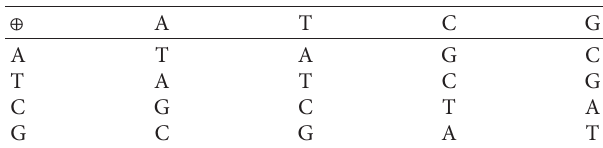
Figure 13: The overall structure of the image encryption and decryption. Table 3: Xor operation.